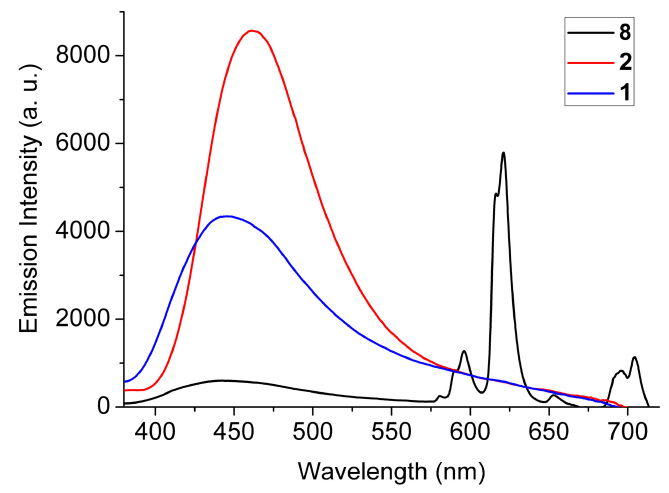
Figure 5. The solid-state emission spectra of compounds 1 , 2 and 8 upon excitation at 365 nm. See main text for details.